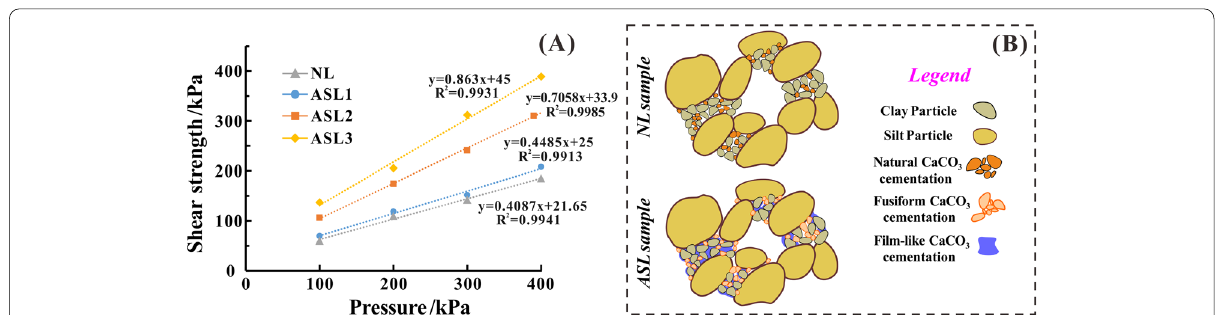
Fig. 5 A Fitted shear strength; B micro-schematic diagram of the NL and ASL samples